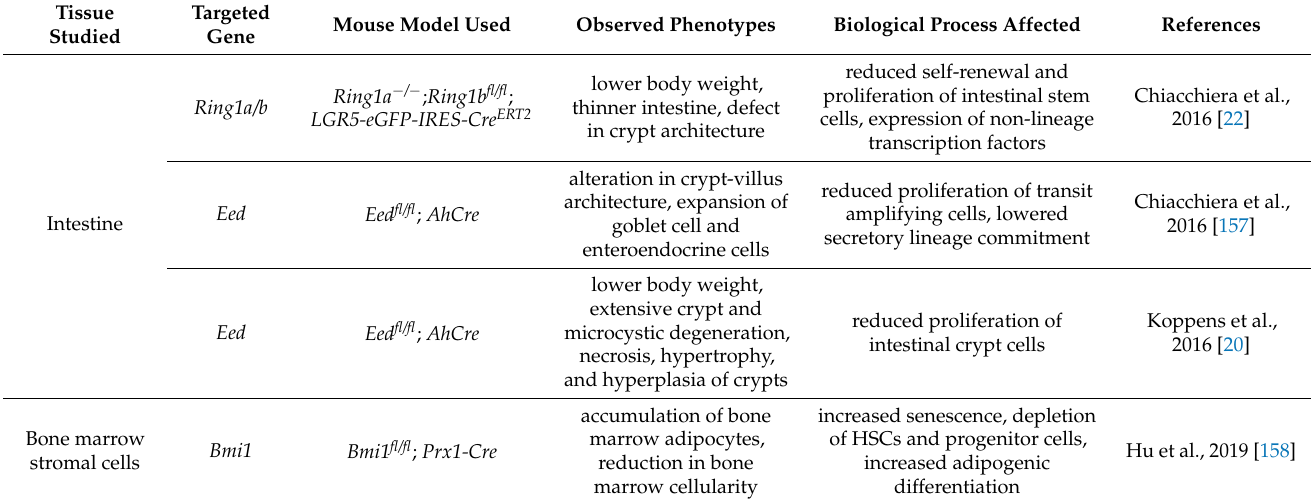
Table 1. Role of PcGs of proteins in adult SC